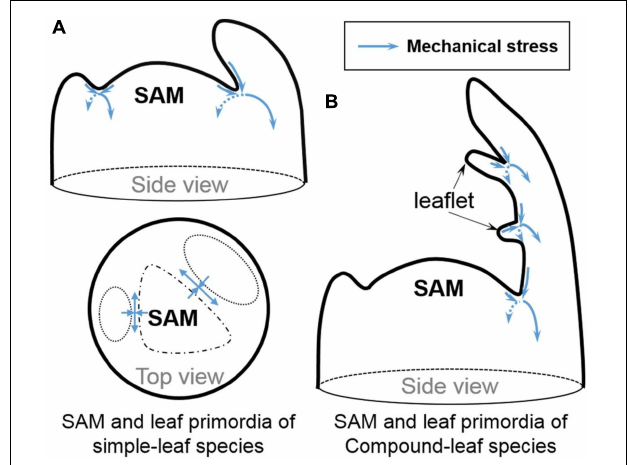
FIGURE 2 | Stress patterns in boundary regions. (A) The anisotropic stress (blue arrows) in the boundary regions between primordia and SAM. (B) The possible anisotropic stress (blue arrows) between leaftlets in compound-leaf species. Modified and inferred from Hussey (1971a); Hamant et al. (2008) and Sampathkumar et al.